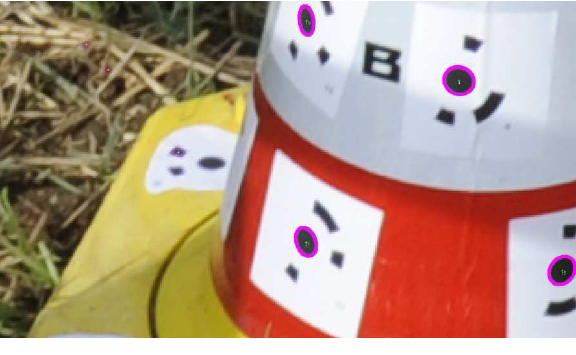
Figure 4: Image point coordinate measurement by ellipse